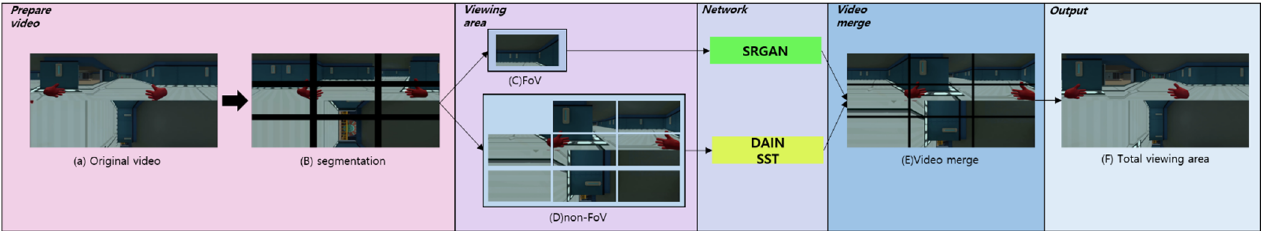
Figure 22. Model processing.